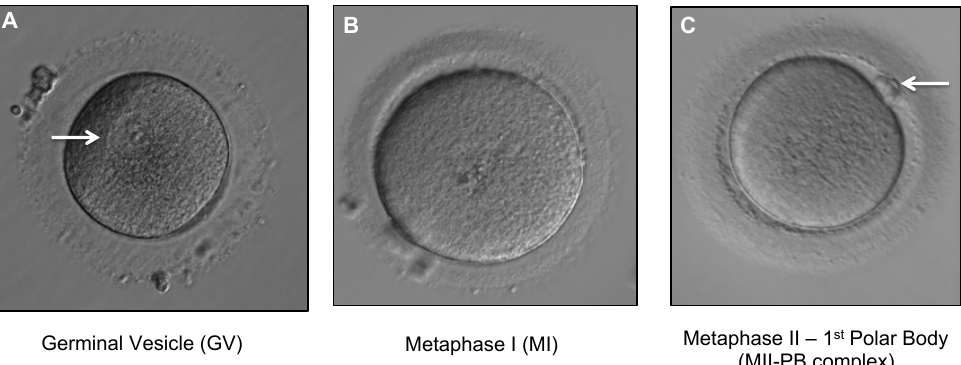
Figure 3. Different stages of oocyte maturation. All oocytes were denuded (removal of the surround- ing layer of cumulus cells). ( A ) Immature GV oocyte. Arrow indicates a germinal vesicle (visible nucleus) with a prominent single nucleolus (400 × magnification). ( B ) Immature MI oocyte showing absence of germinal vesicle and no 1st PB (400 × magnification). ( C ) MII-PB complex (mature MII oocyte with 1st PB). Arrow indicates 1st PB (400 ×